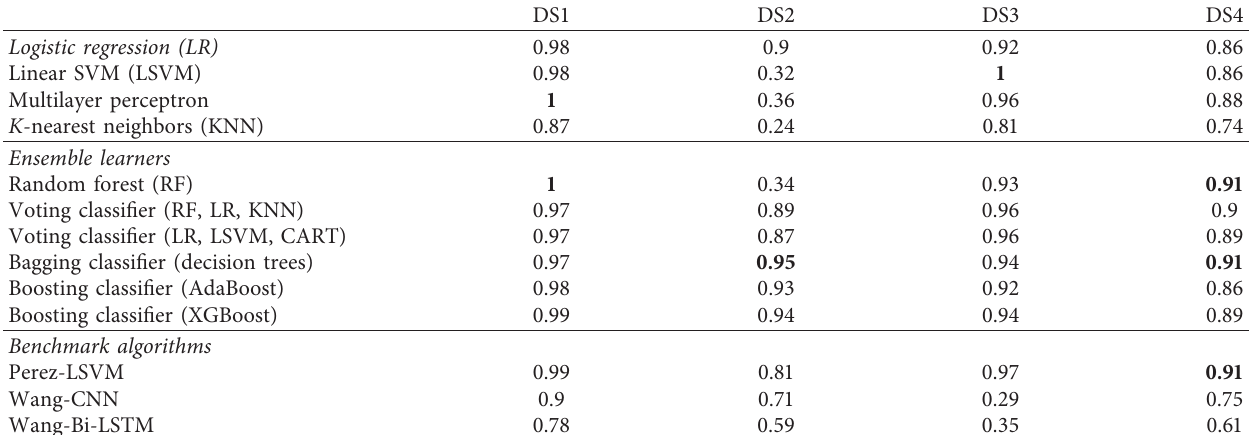
Table 4: Recall on the 4